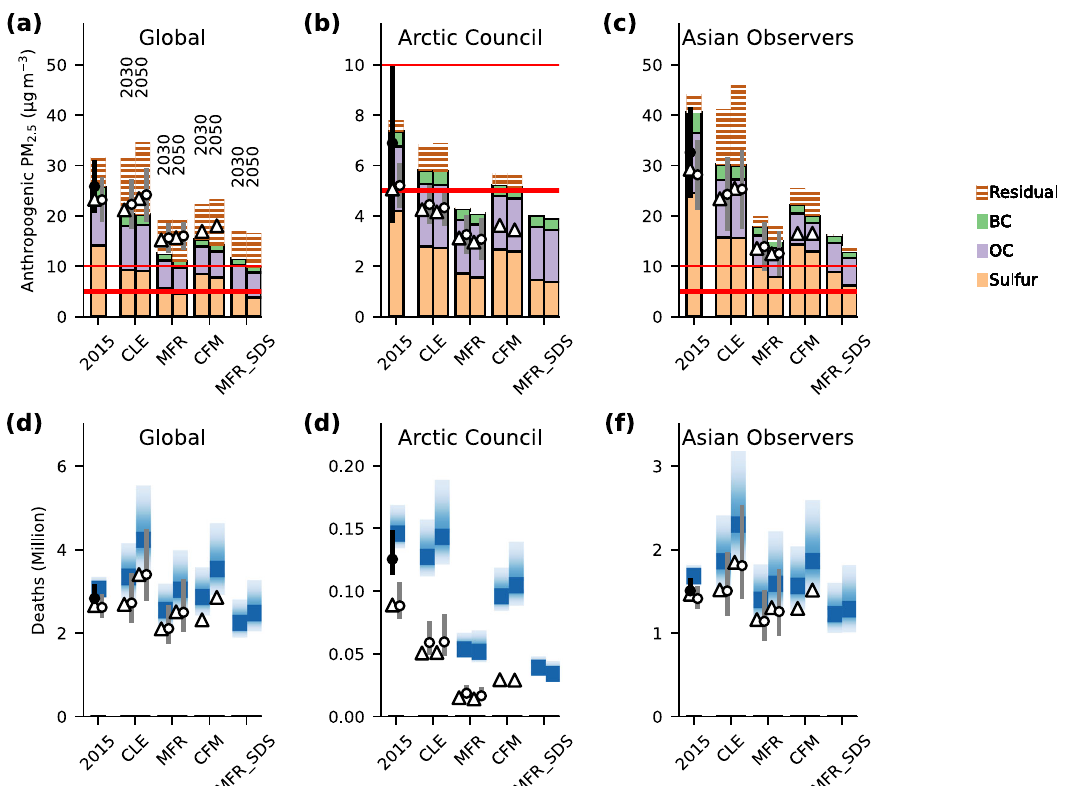
Fig. 4 Particulate matter impacts on human health. a – c show population-weighted PM 2.5 concentrations in three different regions for a 2015 baseline and 4 future AMAP scenarios. Anthropogenic and biomass PM 2.5 components from global emissions of sulfur, OC, and BC (color bars, legend) are based on emulator simulations. Additional residual PM 2.5 components (primarily sea salt, mineral dust, and nitrate) and total PM 2.5 from all components are based on simulations with the TM5-FASST model (full bars). Black bullets refer to corresponding multi-model mean population-weighted anthropogenic and biomass PM 2.5 from simulations with 10 global Earth System Models (ESMs) and Chemistry Transport Models (CTMs) for 2015. White circles are for a subset of 5 models which also provided results for years 2030 and 2050. White triangles refer to results from the MRI-ESM2, the only ESM simulating the CFM scenario. World Health Organization ’ s Air Quality Guidelines from 2021 (5 µ g/m 3 ) and 2005 (10 µ g/m 3 ) are indicated by red lines. d – f show mean deaths in the same regions, based on simulations with the TM5-FASST model (blue squares). Additional mortality estimates from simulations with ESMs and CTMs are shown, too. Con fi dence intervals (error bars) are indicated by vertical lines for the full model ensemble (black), model subset (grey), and TM5-FASST (blue shading). See Supplementary Notes 5, 6 for model